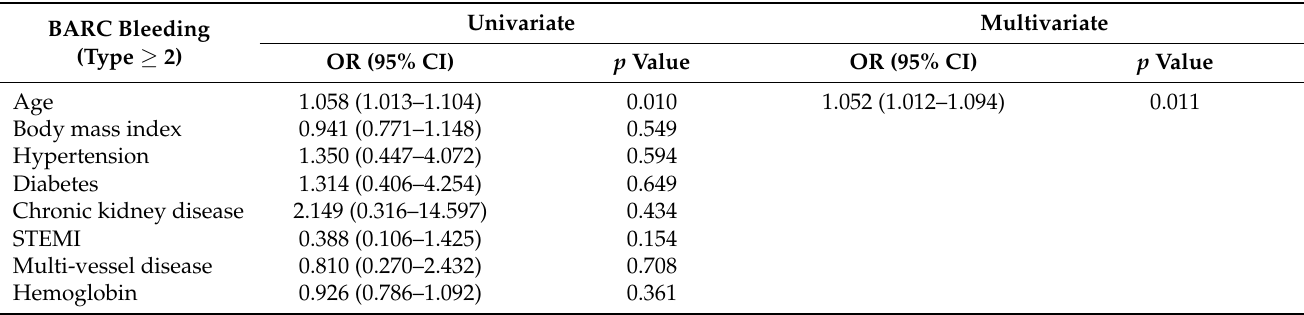
Figure 2. Incidence and temporal change of nuisance bleeding (BARC type 1) ( A ) and serious bleeding (BARC type ≥ 2) ( B ) over time during half- vs. standard-dose ticagrelor. Exponentiation of the B coefficient was calculated with standard-dose ticagrelor as a reference. BARC = Bleeding Academic Research Consortium; CI = confidence interval; OR = odds ratio. Table 2. Comparisons of primary and secondary endpoints in half vs. standard-dose ticagrelor during 6 months. Table 3. Independent predictors of bleeding and dyspnea